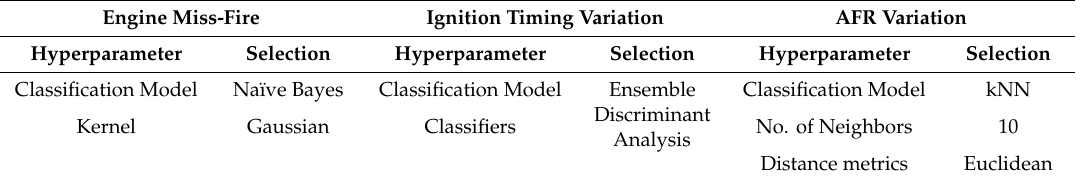
Table 4. Optimal model selection for Model 1—using a standard model.